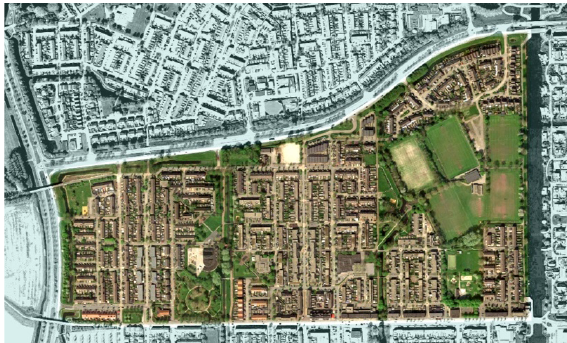
Figure 20. Waterwijk (phase 1): aerial map. Source: